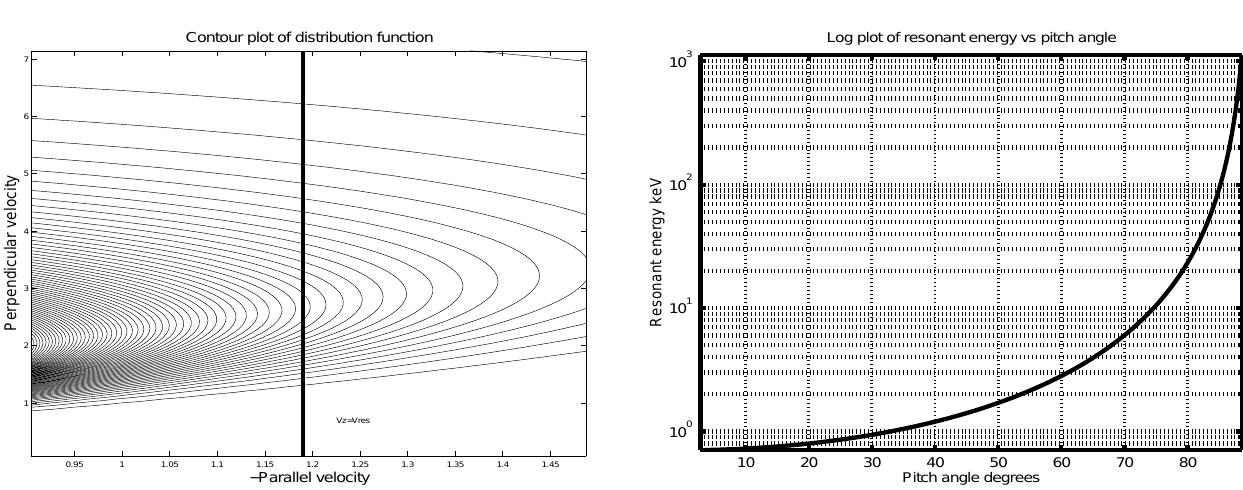
Fig. 1. Contour plot in equatorial V z , | V ⊥ | space of the “pan- cake” distribution function of Bell et al. (2000). Velocities are in dimensionless units.